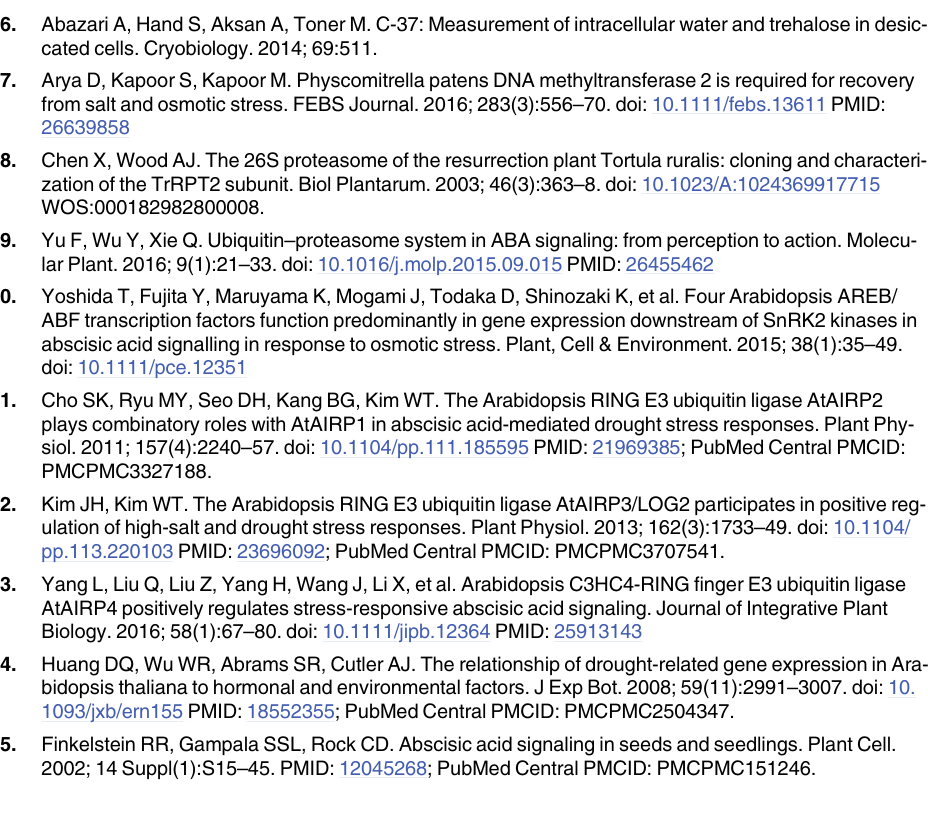
PLOS ONE | DOI:10.1371/journal.pone.0155455 May 26,